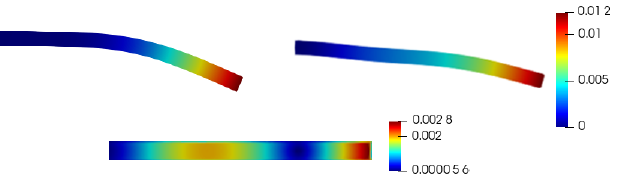
Figure 18. Deformation of the structure: FE solution ( top left ), reduced order solution ( top right ), and local approximation error ( bottom ). The approximation was obtained with N d functions. The deformation was magnified by a factor 10 for visualization purposes.